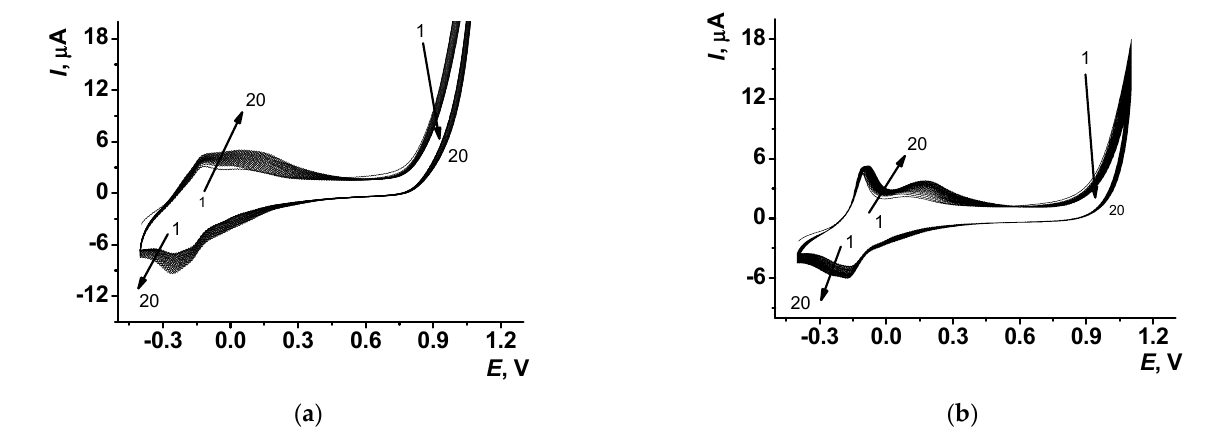
Figure 2. Cyclic voltammograms recorded on the GCE in 0.1 M HEPES buffer containing 0.03 M NaCl, pH = 7.0, and 0.5 mM Azure B, scan rate 100 mV/s in the absence ( a ) and in the presence ( b ) of chloroform, 20 cycles. The addition of chloroform to the electropolymerization solution slightly shifts the monomer redox peak potentials to the cathodic direction and the polymer redox peak potentials significantly shift to the anodic area. After being transferred to the working buffer with no monomer, the GCE modified with PAB-1 and PAB-2 layers demonstrated two pairs of the peaks on the cyclic voltammograms (Figure 3).